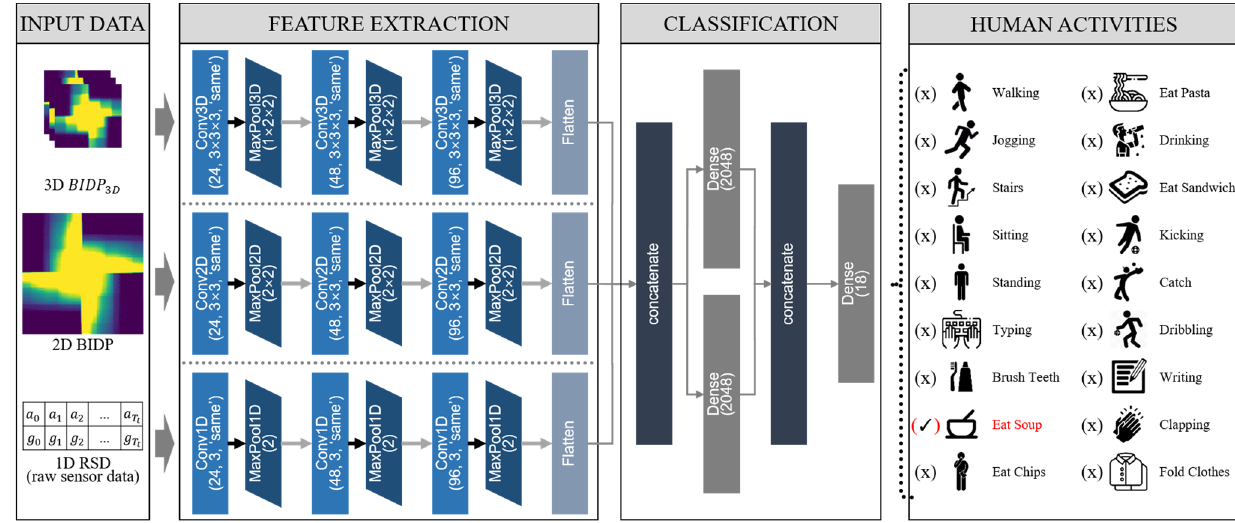
Figure 12. A Proposed multi-dimensional convolutional neural network.